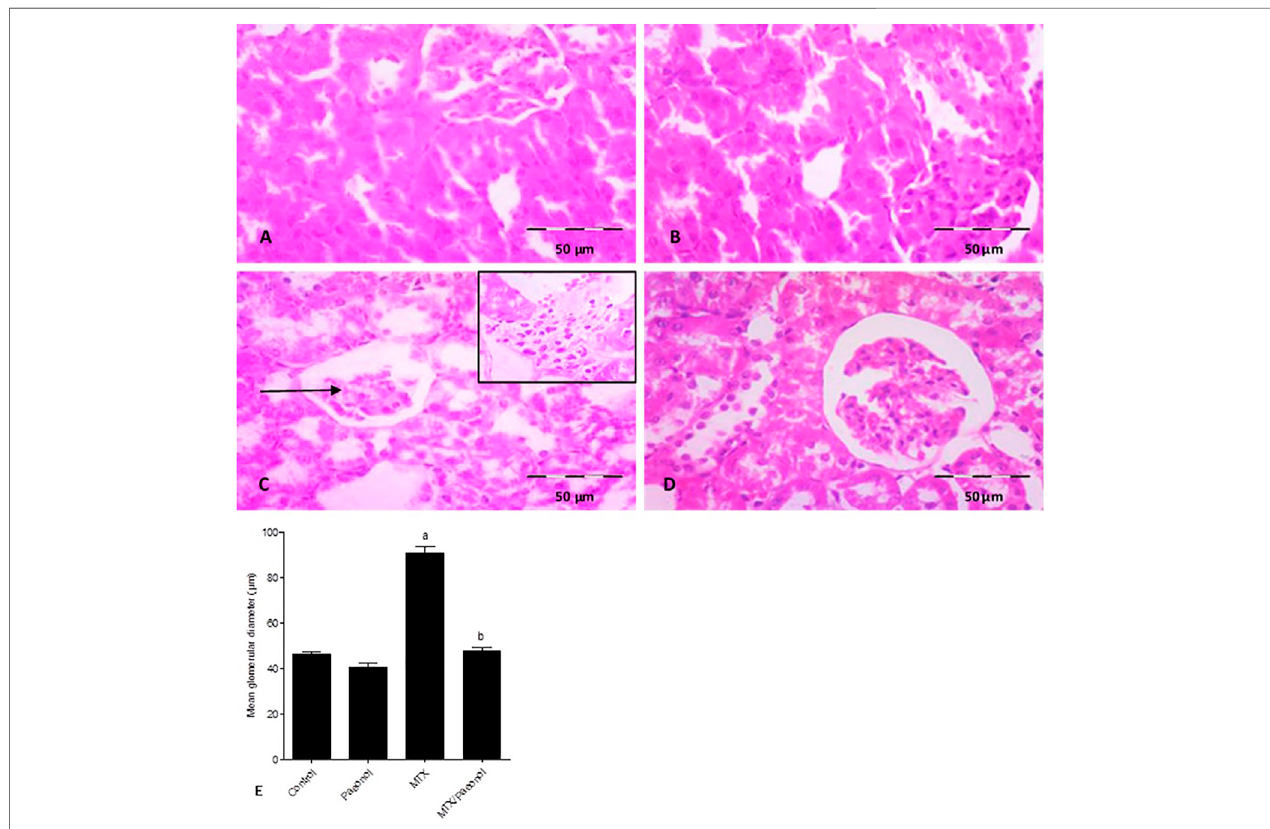
FIGURE 1 | Histopathological picture of the kidney after methotrexate (MTX) and/or paeonol administration stained by hematoxylin and eosin (H and E). A photomicrograph of the rat kidney (×100) from (A) control, (B) paeonol-treated, (C) MTX-treated, and (D) MTX/paeonol-treated rats. Black arrow shows shrunken renal corpuscle, and the insert shows cellular in fi ltration. (E) Mean glomerular diameter obtained from sections of each animal ( n = 6 for each group), six fi elds/section, where results were considered signi fi cantly different when p < .05. a,b Signi fi cant difference compared to control or MTX groups, respectively.